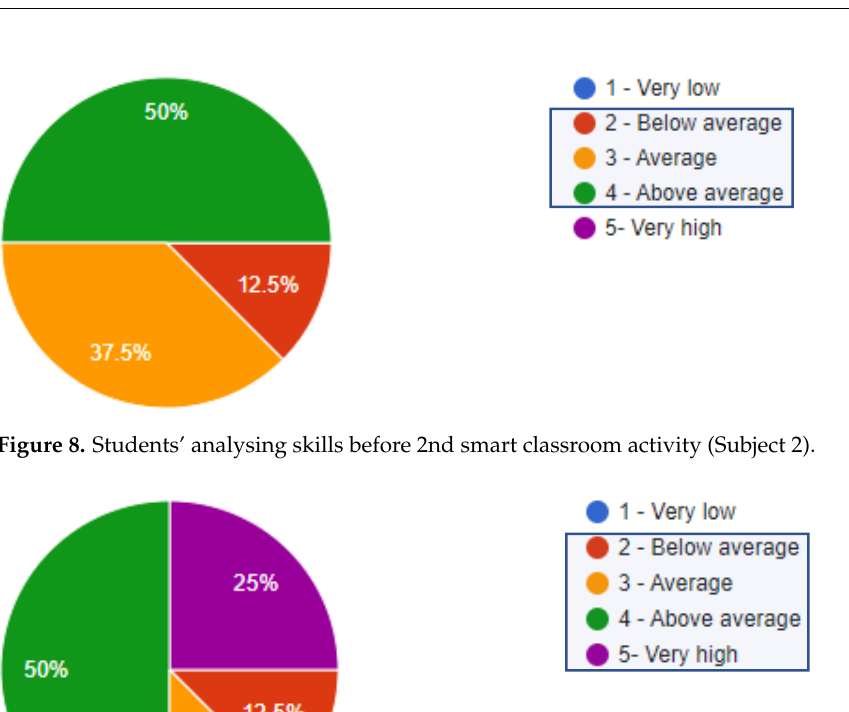
Figure 7. Students’ analysing skills after 1st smart classroom activity (Subject 1).